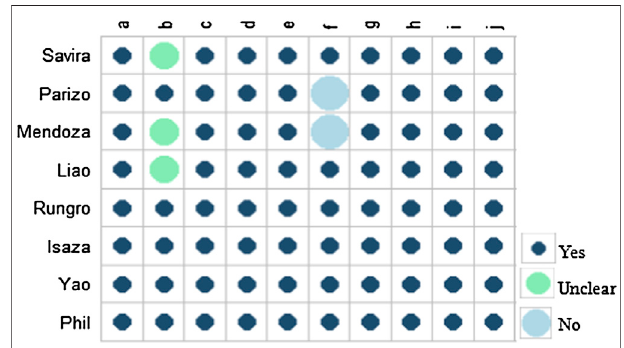
FIGURE 2 | Quality assessment of the included studies. (A) Was a well- de fi ned question posed in an answerable form? (B) Was a comprehensive description of the competing alternatives given? (C) Was the effectiveness of the programs or services established? (D) Were all the important and relevant costs and consequences for each alternative identi fi ed? (E) Were costs and consequences measured accurately in appropriate physical units? (F) Were costs and consequences valued credibly? (G) Were costs and consequences adjusted for differential timing? (H) Was an incremental analysis of costs and consequences of alternatives performed? (I) Was allowance made for uncertainty in the estimates of costs and consequences? (J) Did the presentation and discussion of study results include all issues of concern to the